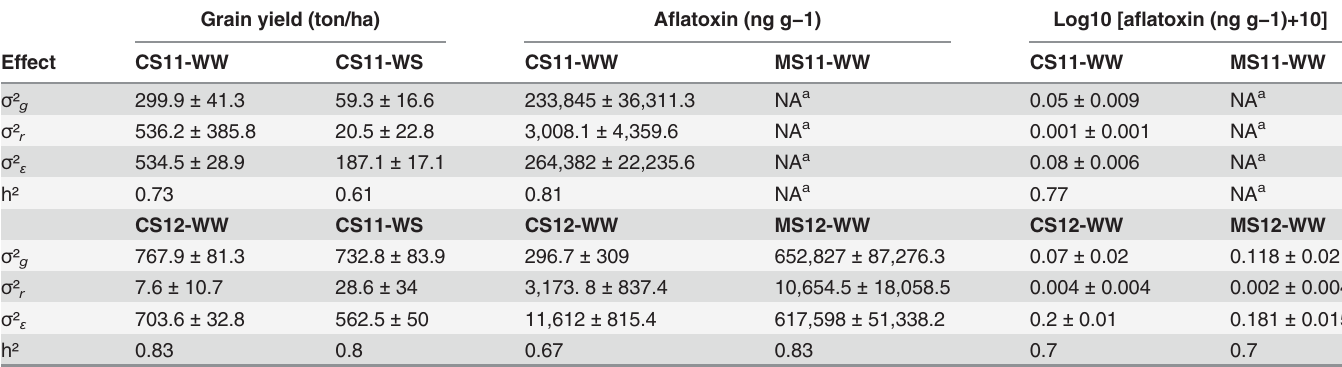
Table 1. Variance components and heritability estimates for each individual trial. Grain yield